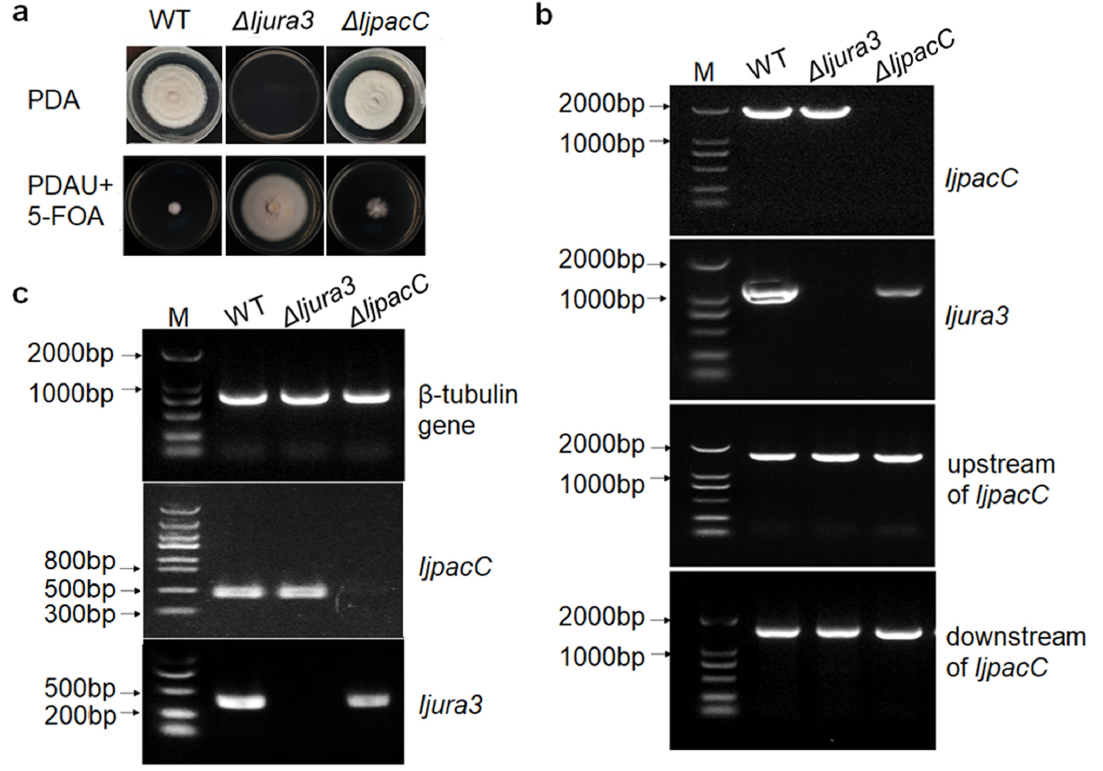
Figure 2. Verification of PacC gene deletion in I. javanica. ( a ) Colony of the wild-type, Ijura3 mutant, and IjpacC mutant strains grown on PDA and PDA with 0.5 mg/mL uridine and 1 mg/mL 5-FOA at 25 °C for 20 days. ( b ) PCR detection of different fragments. ( c ) RT-PCR detection of gene expressions of IjpacC and Ijura3 in different strains, with expression of β -tubulin gene as control.